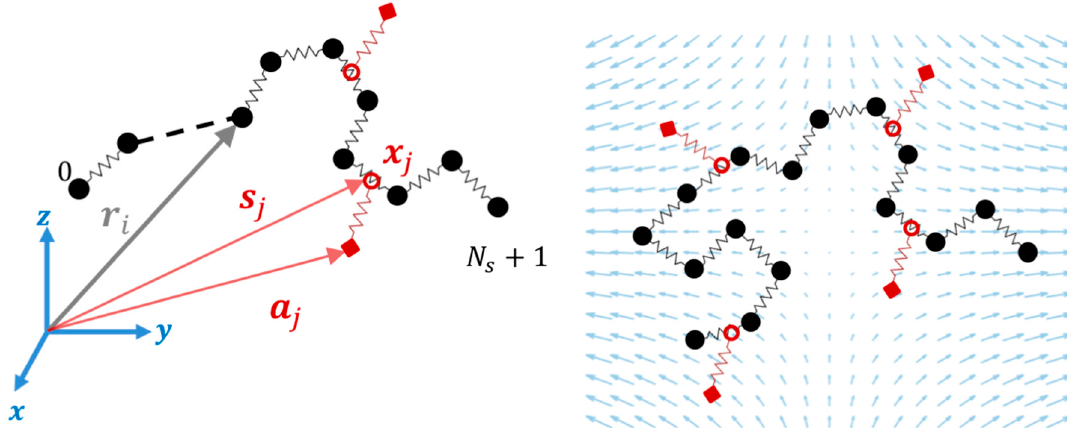
Figure 6. Schematic of slip-spring simulation in an extensional flow. Position vector of a bead ( r i ), anchoring point of a slip-spring ( a j ), position of a slip-link on the chain ( s j ), and a dummy variable ( x j ) of a slip-spring along a chain are shown on the left. On the right, a uniaxial extensional flow is applied to this single-chain model of an entangled polymer, where each slip-spring anchoring point (red squares) moves affinely with the flow until the force generated in the virtual spring (red) reaches a maximum value.